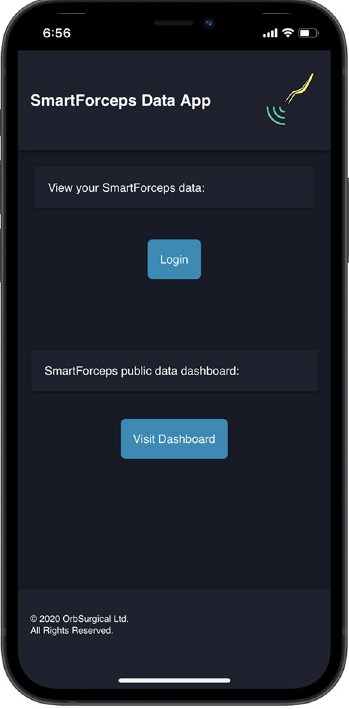
Figure 2. Design interface of the SmartForceps surgical data monitoring application on a mobile device. The user can click to visit the general dashboard without login or login with exclusive credentials to visit their own reports in surgeon or data scientist views. Visualization created through framing the PWA created in JavaScript inside a phone view using MockuPhone mock-up generator: https:// mocku phone.